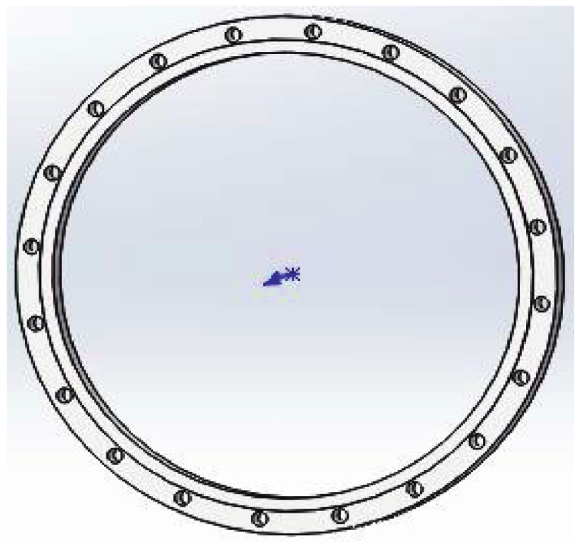
Figure 10: Three-dimensional view of the flange.